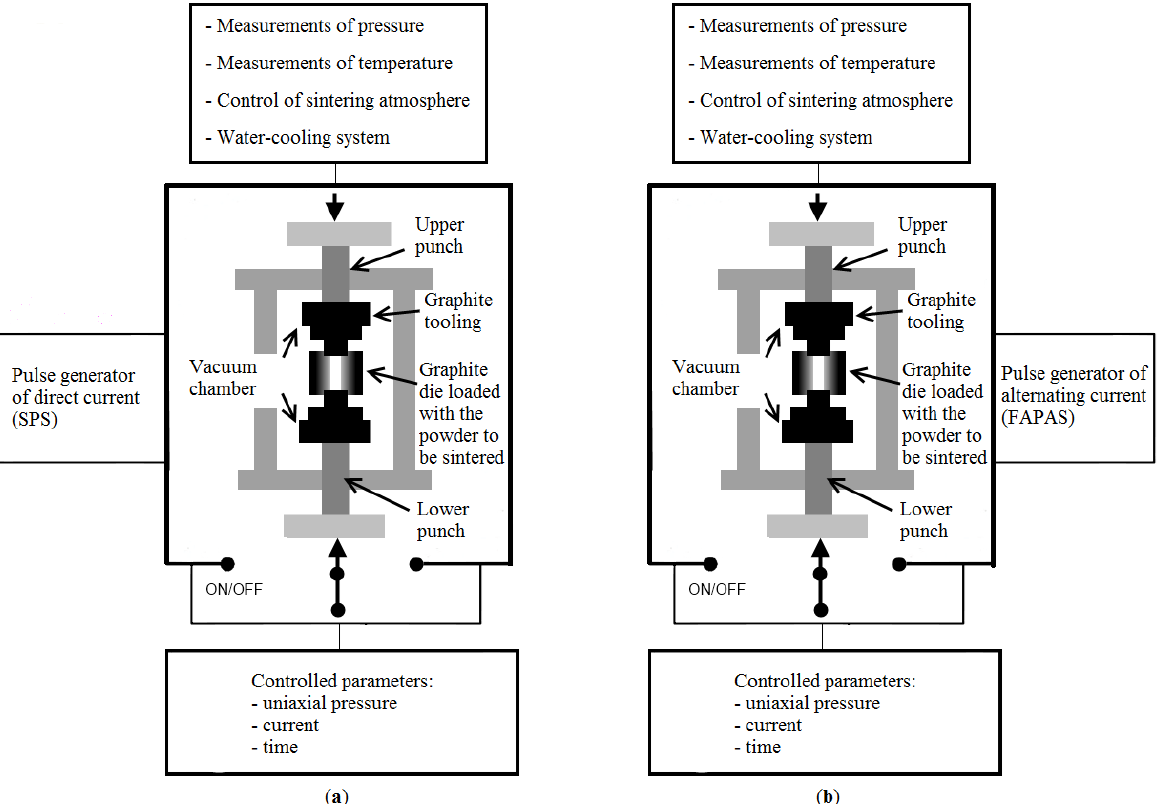
Figure 18. ( a ) Schematic of spark plasma sintering (SPS) and ( b ) field activated pressure assisted synthesis (FAPAS) facilities.